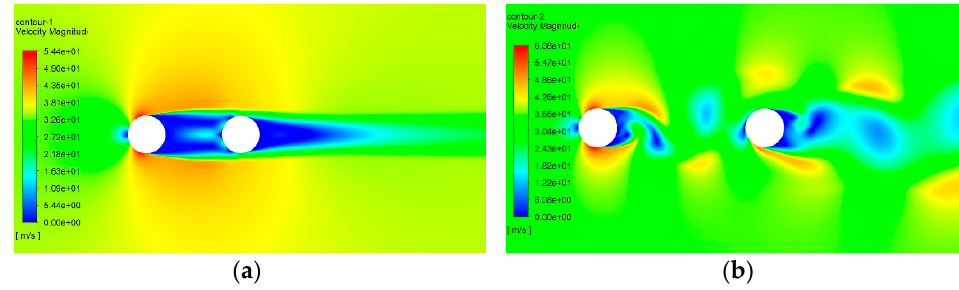
Figure 12. Velocity contours for twin cylinders arranged in tandem: ( a ) W/D = 2.5; ( b ) W/D = 4.3. When twin cylinders are placed in a staggered arrangement, things become different.